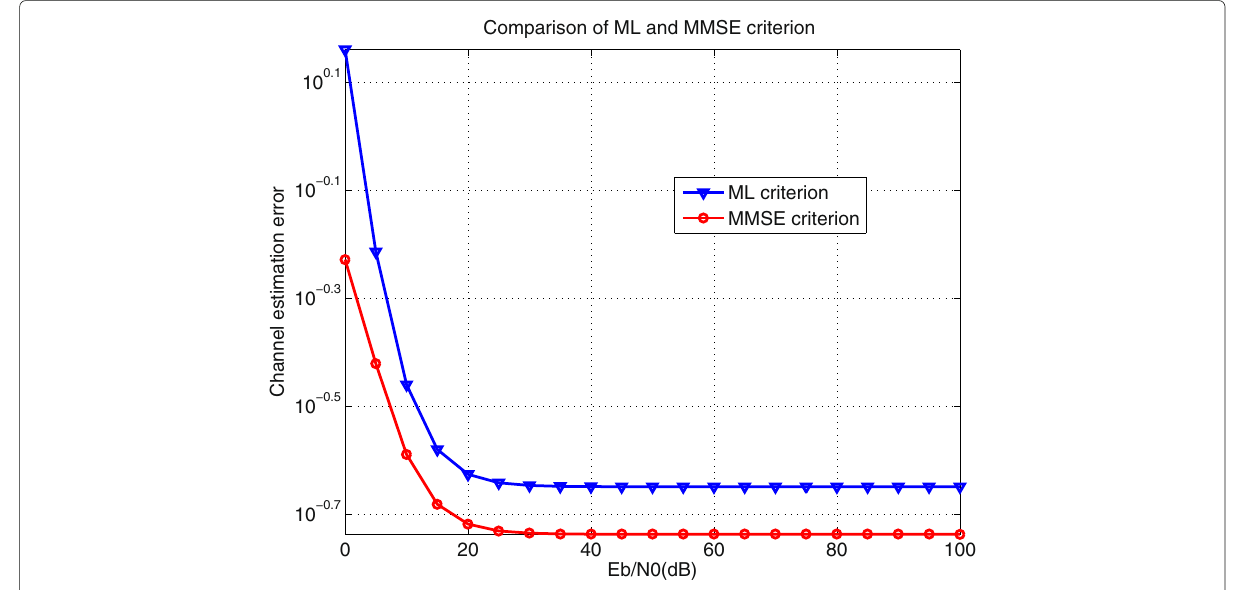
Fig. 3 Comparison of ML and MMSE criterion with f D T s =